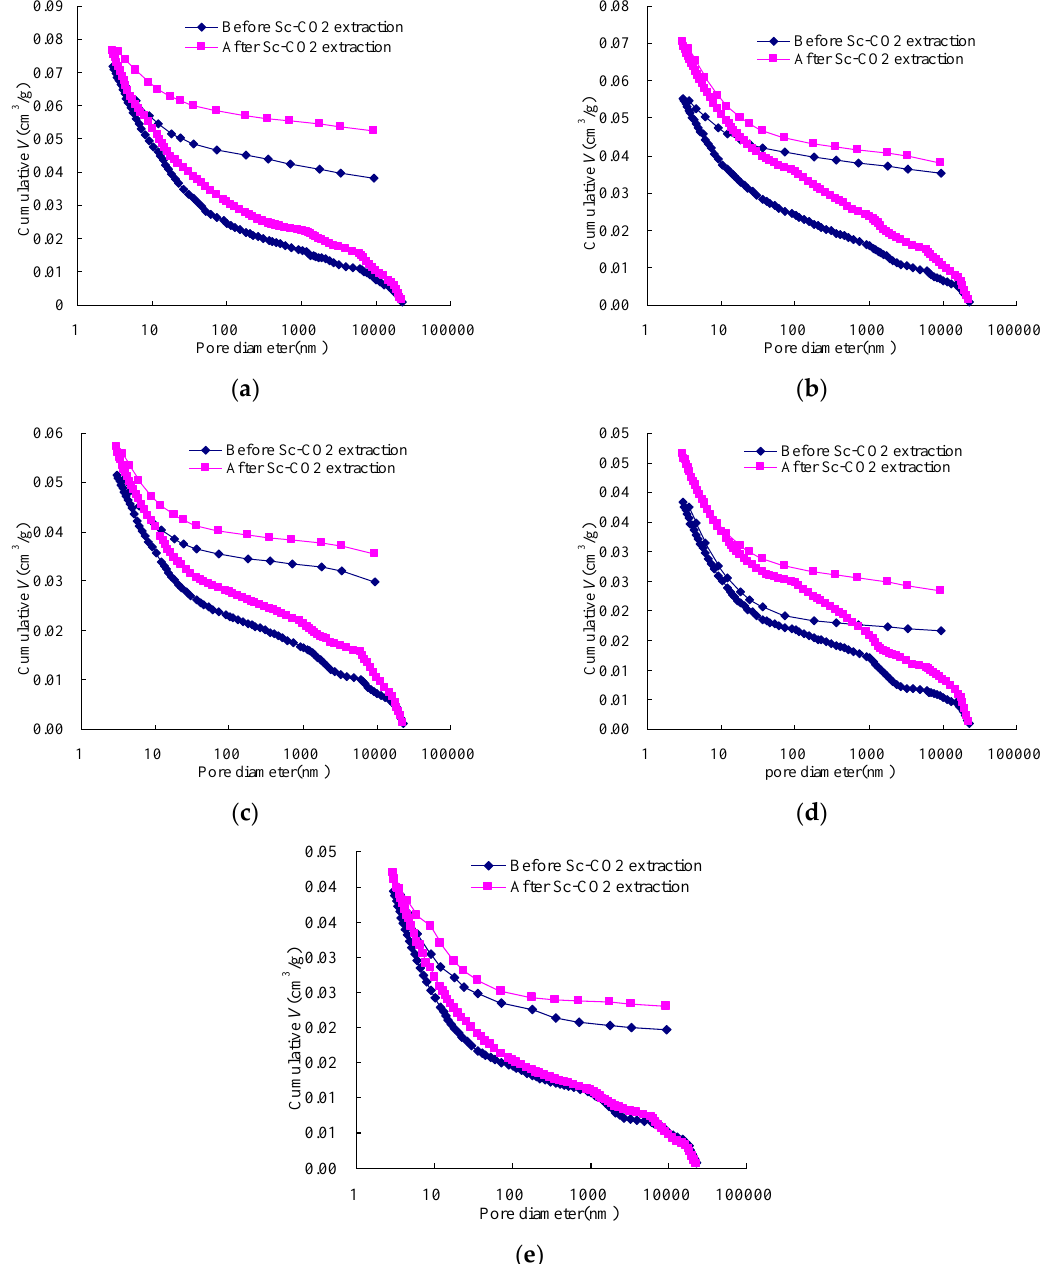
Figure 5. Cumulative pore volumes of the samples before and after Sc-CO 2 extraction as a function of pore size diameter: ( a ) Qiyi coal; ( b ) Liulin coal; ( c ) Dengjiazhuang coal; ( d ) Shuangliu coal; ( e ) Maozequ coal.